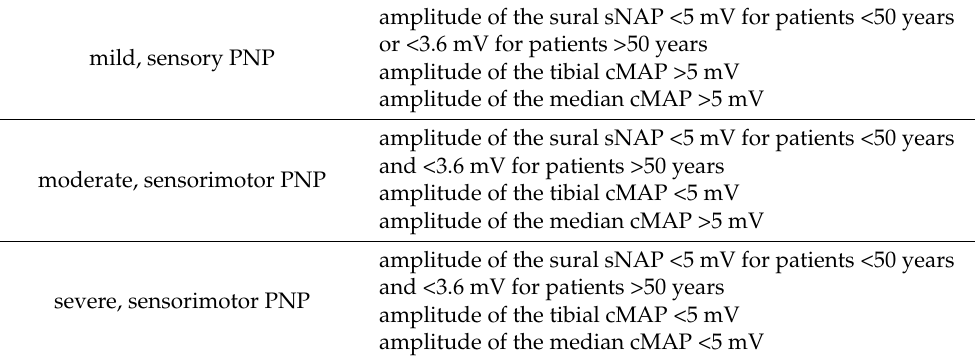
Table 2. Electrophysiological classification for PNP severity. amplitude of the sural sNAP <5 mV for patients <50 years or <3.6 mV for patients >50 years mild, sensory PNP amplitude of the tibial cMAP >5 mV amplitude of the median cMAP >5 mV amplitude of the sural sNAP <5 mV for patients <50 years and <3.6 mV for patients >50 years moderate, sensorimotor PNP amplitude of the tibial cMAP <5 mV amplitude of the median cMAP >5 mV amplitude of the sural sNAP <5 mV for patients <50 years and <3.6 mV for patients >50 years severe, sensorimotor PNP amplitude of the tibial cMAP <5 mV amplitude of the median cMAP <5